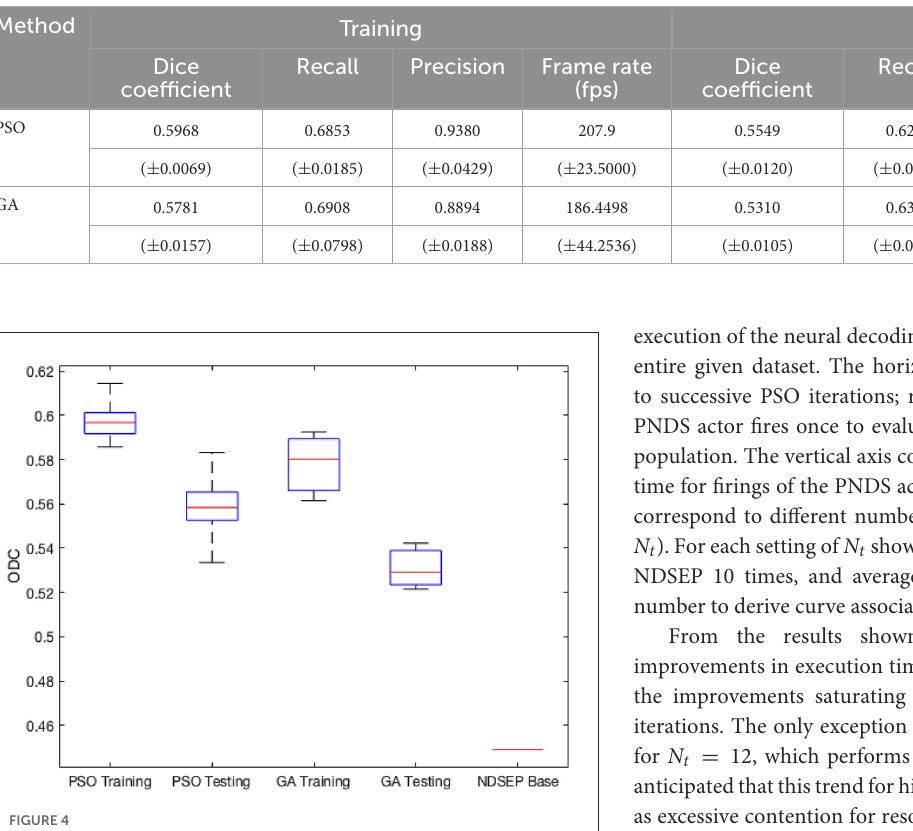
TABLE 5 Training and testing results for NEDECO-PSO-CellSort and NEDECO-GA-CellSort.